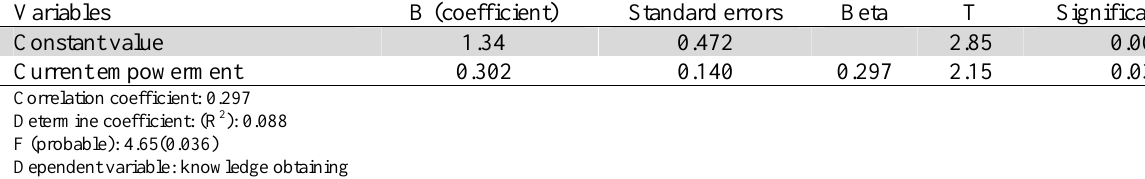
Regression model of effect of employee’s psychological empowerment on knowledge obtaining